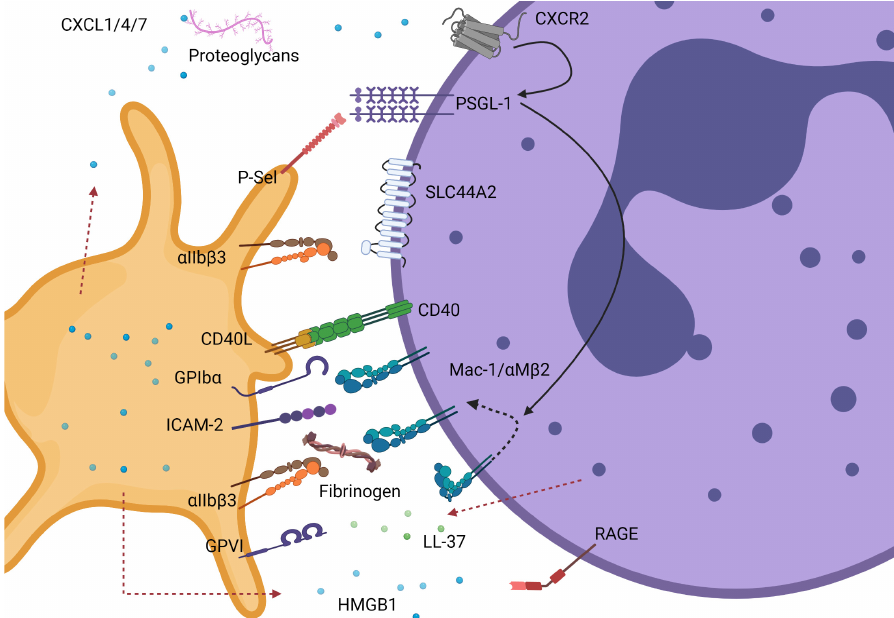
Figure 1. Known interactions between platelets and neutrophils. These can be mediated by direct contact between platelet and neutrophil receptors or indirectly via secreted ligands or molecules present in plasma. Most of these interactions require either the platelet and/or the neutrophil to be activated. Neutrophils can interact via PSGL-1 or CD40 with P-selectin and CD40L, respectively, on activated platelets. PSGL-1 binding to P-selectin triggers downstream signalling in neutrophils (black solid lines) leading to Mac-1 integrin conformational change from a closed to open conformation (dotted black line). These events can be enhanced by cooperative signals from CXCL1/4/7 immobilised by proteoglycans binding to CXCR2 or Mac-1. Activated Mac-1 can further promote binding to platelets directly via GPIb α or ICAM-2 or indirectly via fibrinogen-bound α IIb β 3 . Additional depicted interactions are granule-release HMGB1 from platelets with neutrophil RAGE receptor promoting further neutrophil activation and LL-37 released from neutrophils (dotted red line) activating platelets via GPVI. Lastly, direct binding of activated α IIb β 3 to neutrophil receptor SLC44A2 can trigger neutrophil activation and NET formation. GPIb α - glycoprotein Ib α ; GPVI- glycoprotein VI; ICAM-2- intracellular adhesion molecule 2; CD40L- CD40 Ligand; P-sel- P-selectin (CD62P); CXCL- C-X-C Motif Chemokine Ligand; HMGB1- High mobility group box 1 protein; PSGL-1- P-selectin glycoprotein ligand; SLC44A2- solute carrier family 44 member 2 or CTL-2; MAC-1- macrophage 1 antigen or CD11bCD18 or α M β 2 ; LL-37—human cathelicidin antimicrobial peptide; RAGE- receptor of advanced glycation end products. Created by Biorender.com.